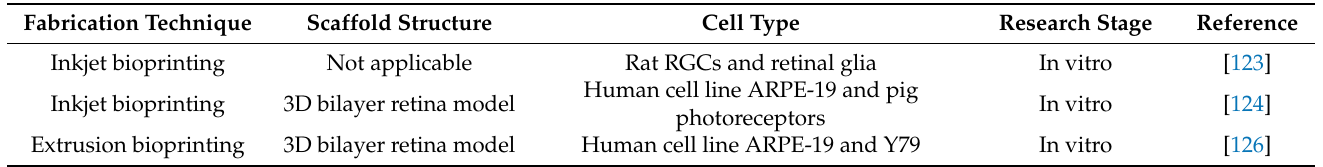
Table 4. A summary of 3D bioprinting techniques used in retinal applications. This table highlights the fabrication technique, the structure of the scaffold and the cell type used. RGC: retinal ganglion cells. Fabrication